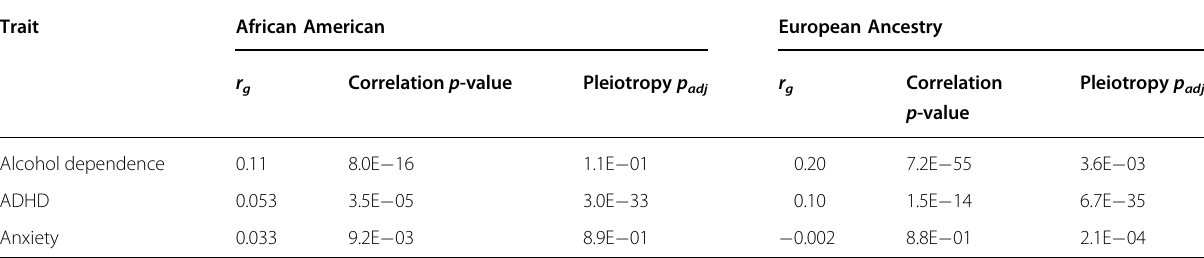
Table 3 Genetic correlation ( r g ) and pleiotropy between stimulant dependence and other psychiatric disorders by population